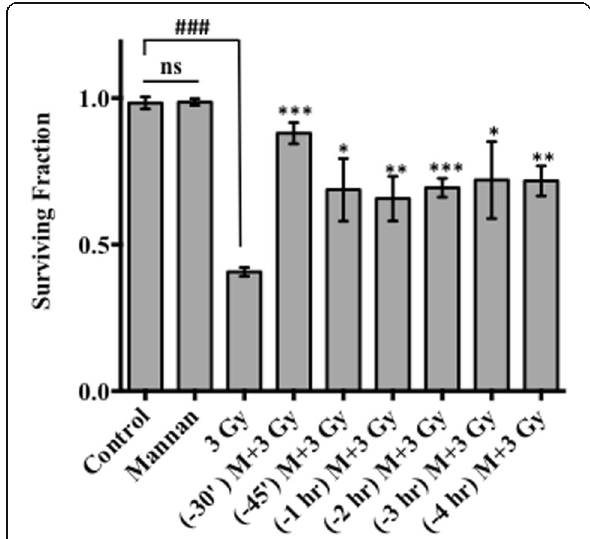
Fig. 4 Clonogenic assay. Effect of pre-irradiation treatment of NKE cells with mannan at different time interval was accessed by using colony forming efficiency (CFE) assay as described in materials and method section. After incubation, formed colonies were fixed, stained and counted. Results are expressed as surviving fraction with respect to control ±SD of three independent experiments. Differences were designated significant at values * p <0.05, ** p <0.001 and *** p <0.0001 and were labeled as # compared with the sham irradiated control group, * compared with the radiation